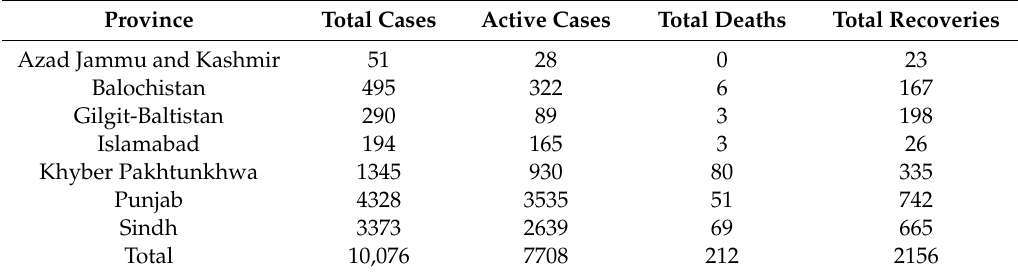
Table 1. Statistics of coronavirus (COVID-19) in Pakistan (as of 22 April 2020) [11]. Province Total Cases Active Cases Total Deaths Total